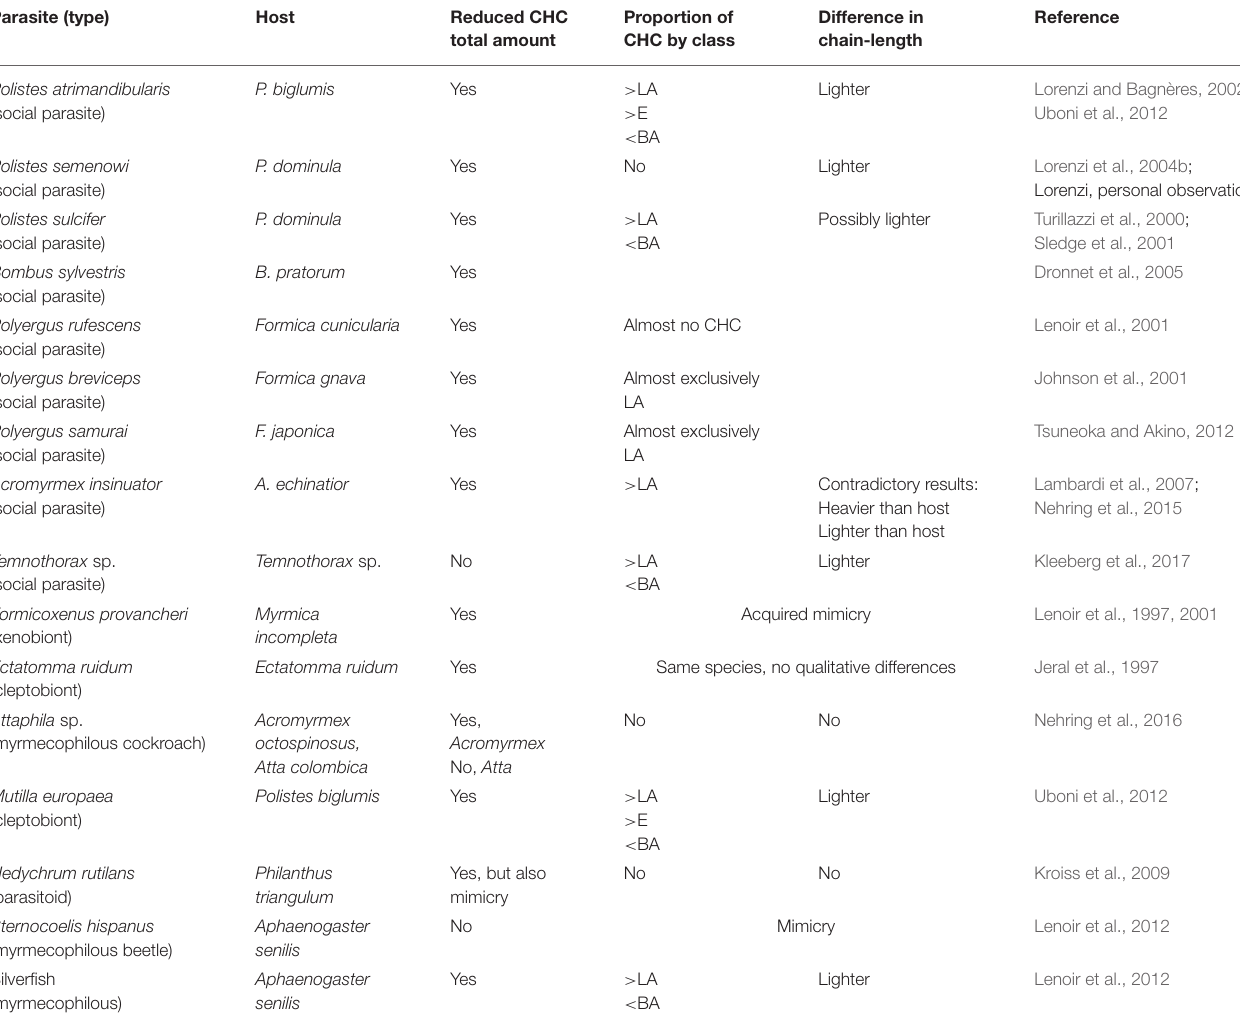
TABLE 1 | Characteristics of the CHC profile of parasites that differ from that of hosts (calculated as “parasites minus hosts”). Parasite